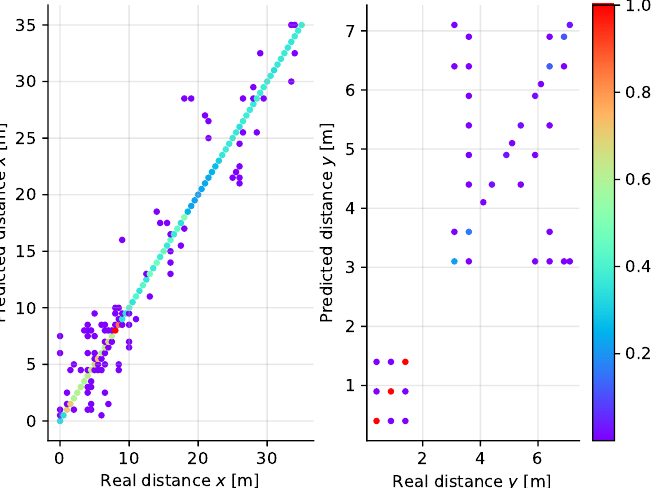
Figure 16. Scatter plot diagram of the real and predicted distance along the X ( left ) and Y ( right ) axes for the k NN classifier applied to two-dimensional localization. The colour of the points corresponds to normalized count of samples at a given position of the plot.